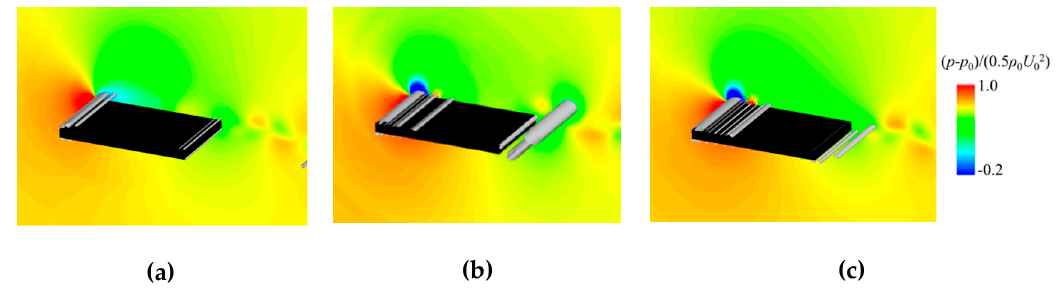
Figure 20. Iso-surfaces of second invariant of velocity gradient tensor and contours of pressure coefficient around oscillating plate under the condition of t 0 / T = 0.5. ( a ) t / T = 0.18; ( b ) t / T = 0.75; coefficient around oscillating plate under the condition of t 0 / T = 0.5. (a) t / T = 0.18; (b) t / T = 0.75; (c) ( c ) t / T = t / T = 0.94.